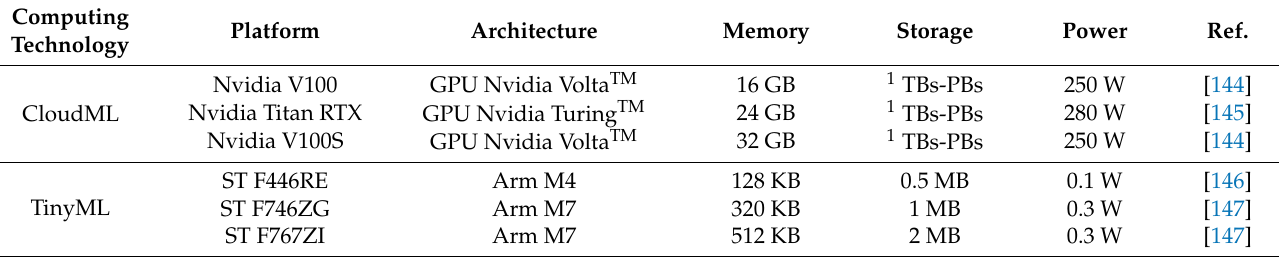
Table 15. Comparison of CloudML and TinyML Platforms.